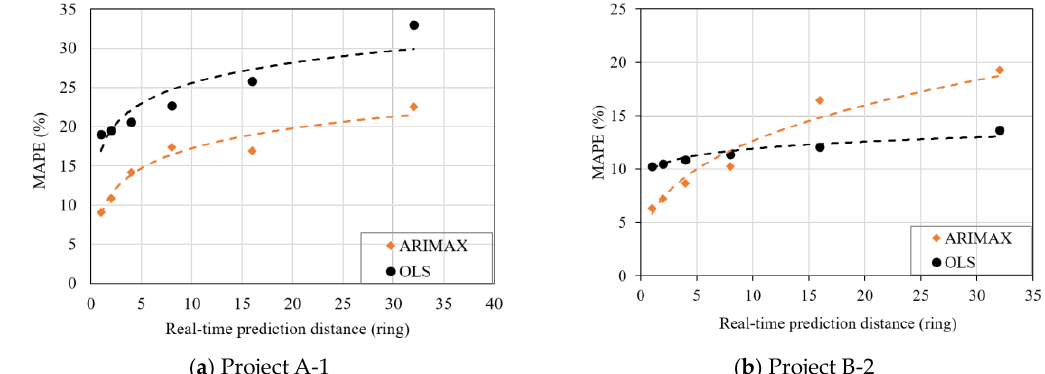
Figure 5. Prediction results of current thrust in project B-2.